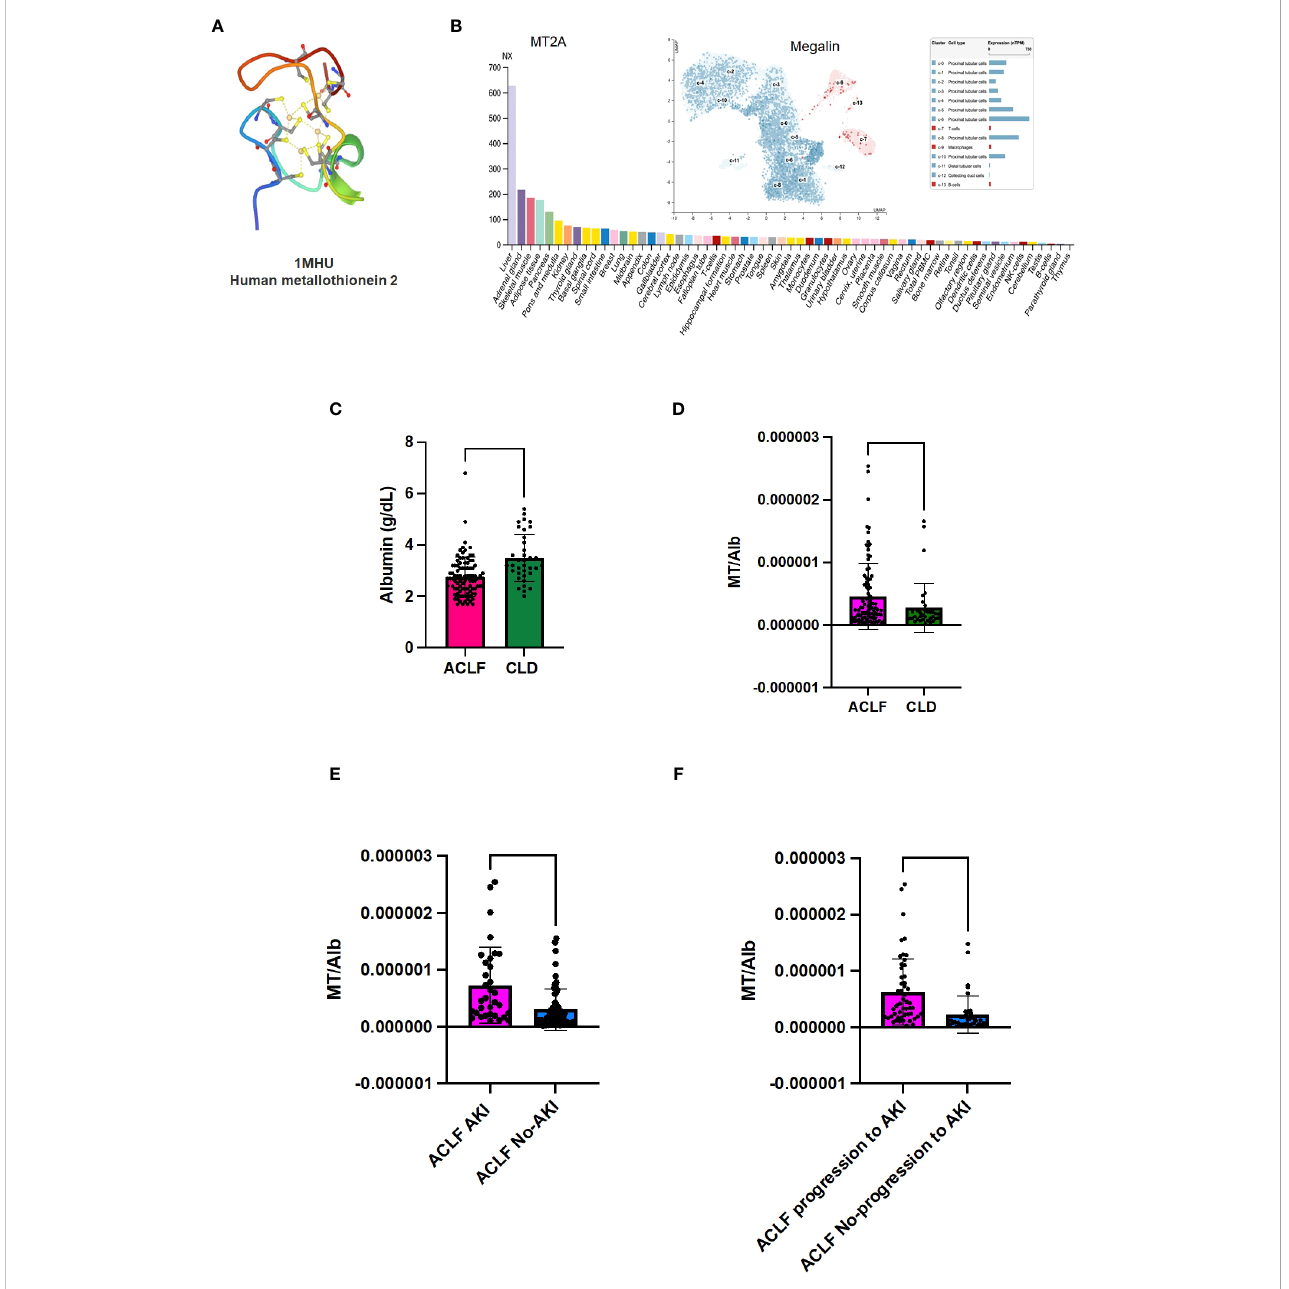
FIGURE 4 Metallothionein (MT) to Albumin (Alb) ratio in ACLF patients. Metallothioneins and Albumin are both ligands for the renal proximal convoluted epithelial cell (RPTEC) receptor Megalin. (A) PDB structure of MT2A; (B) MT2A expression in various tissues shows that it is a liver enriched gene; (B, inset) Expression data for megalin, the scavenger receptor that binds MT, shows that it is expressed at high levels in renal PCT cells; (C) Serum albumin (Alb) levels are signi fi cantly lower in ACLF-AKI patients compared to ACLF no-AKI; MT/Alb is signi fi cantly higher in (D) ACLF vs CLD; (E) ACLF AKI vs ACLF no- AKI and (F) ACLF patients who progress to AKI vs ACLF patients who do not progress to AKI. (**** p-value ≤ 0.0001, ** p-value ≤